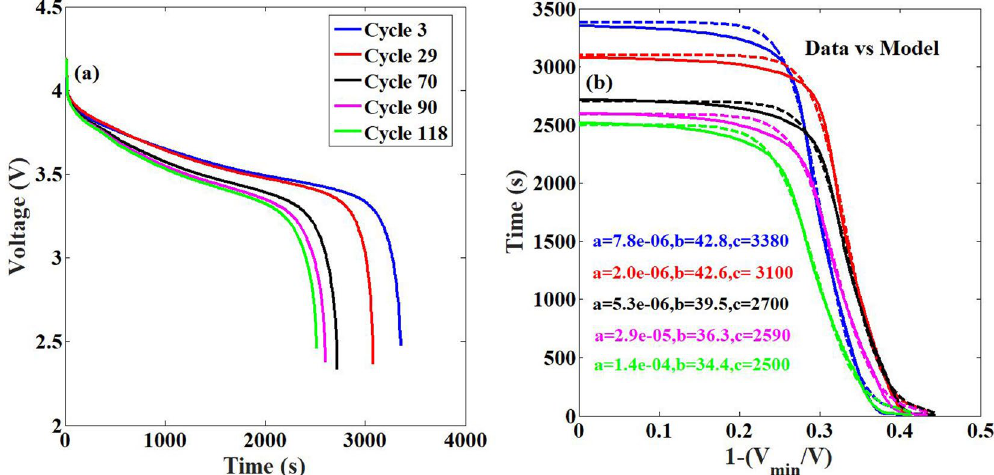
Figure 5. Comparison between simulation data and model prediction for the experimental data on Li-ion battery ageing from the NASA repository 25 . ( a ) The discharge profiles obtained from NASA repository [19] (The file number used is B0018). ( b ) The discharge data rescaled as per the model description (solid lines) and the prediction of the discharge profiles by the model (circles) clearly indicating the presence of only capacity loss in the system. The model parameters are as shown in the legend. The maximum error between the predicted and actual data is < 1%. The value of the parameter ‘d’ is zero in the case which corresponds to the NCA chemistry, as shown in Fig.